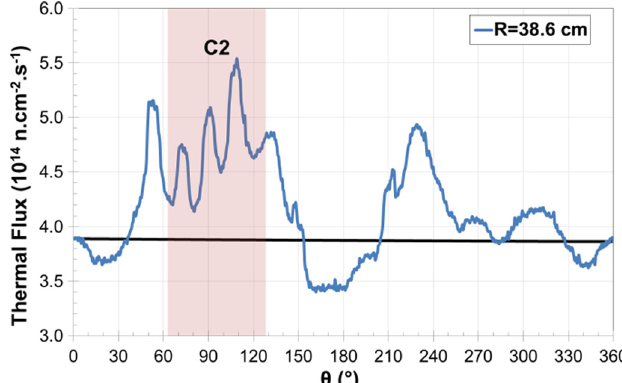
Fig. 11. Azimuthal fl ux distribution for a radius of 38.6 cm, close to pressure vessel and crossing mainly water and aluminum structures.